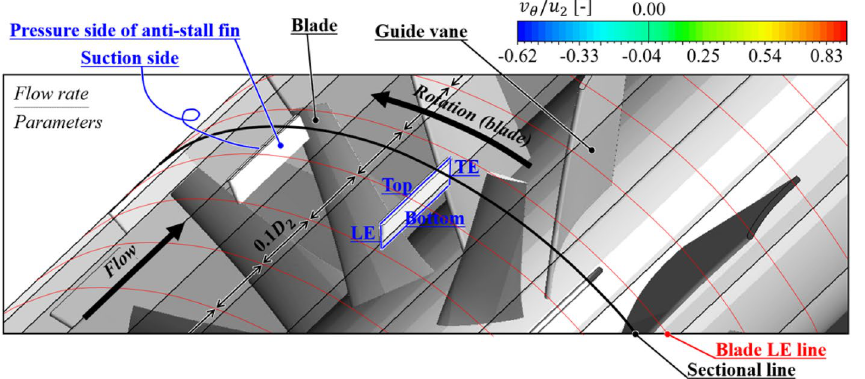
Figure 8. Guide of viewing window in Fig. 4.